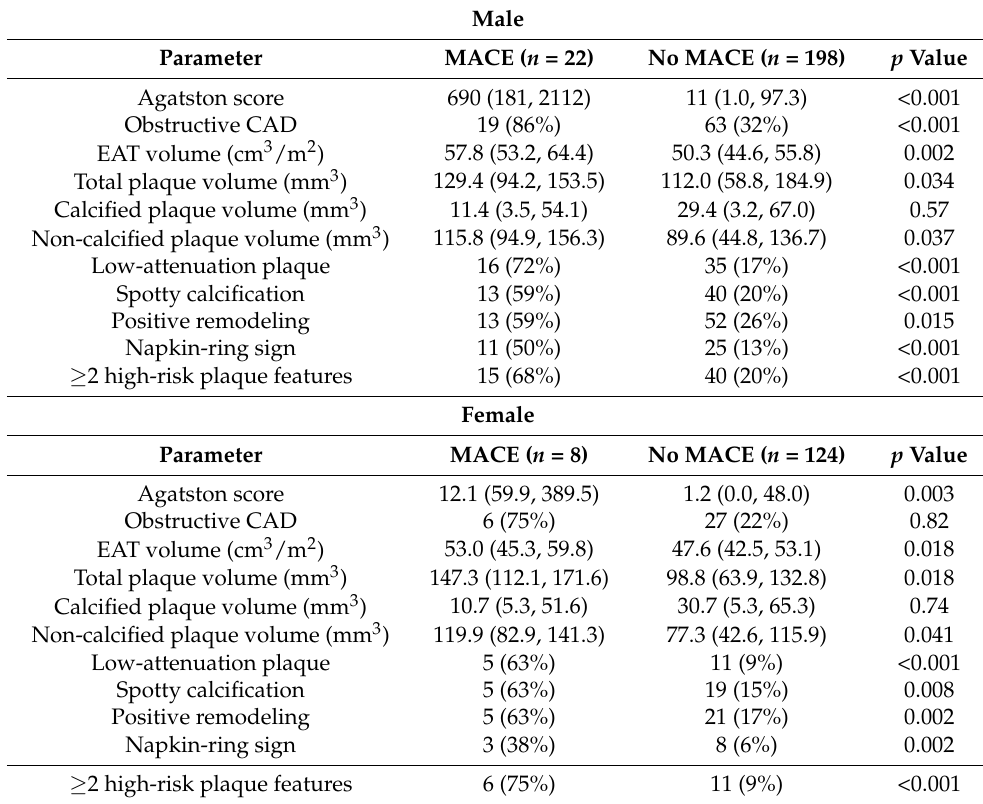
Table 3. Findings of quantitative analysis of coronary CT markers in men and women according to